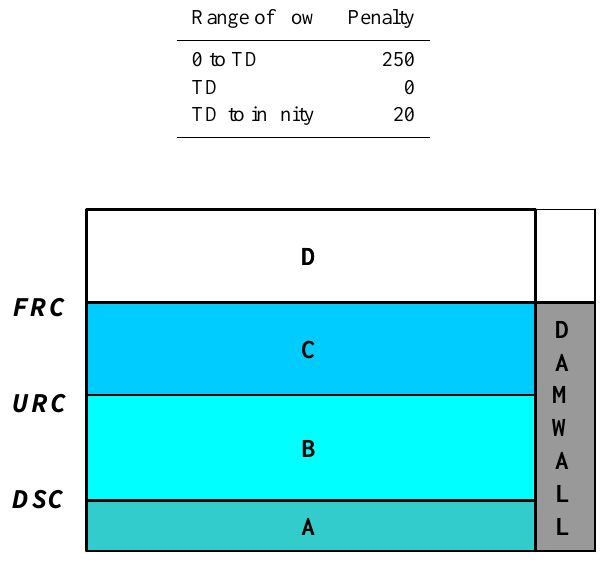
Fig. 4. Storage forms in